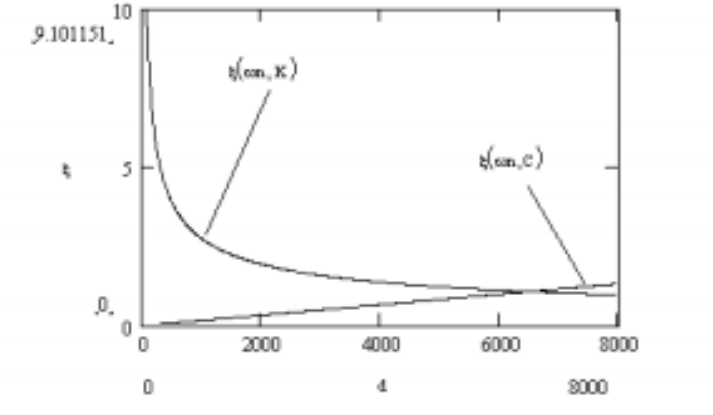
Fig. 2. The change of damping ratio versus to stiffness and damping for ν = 0.225.